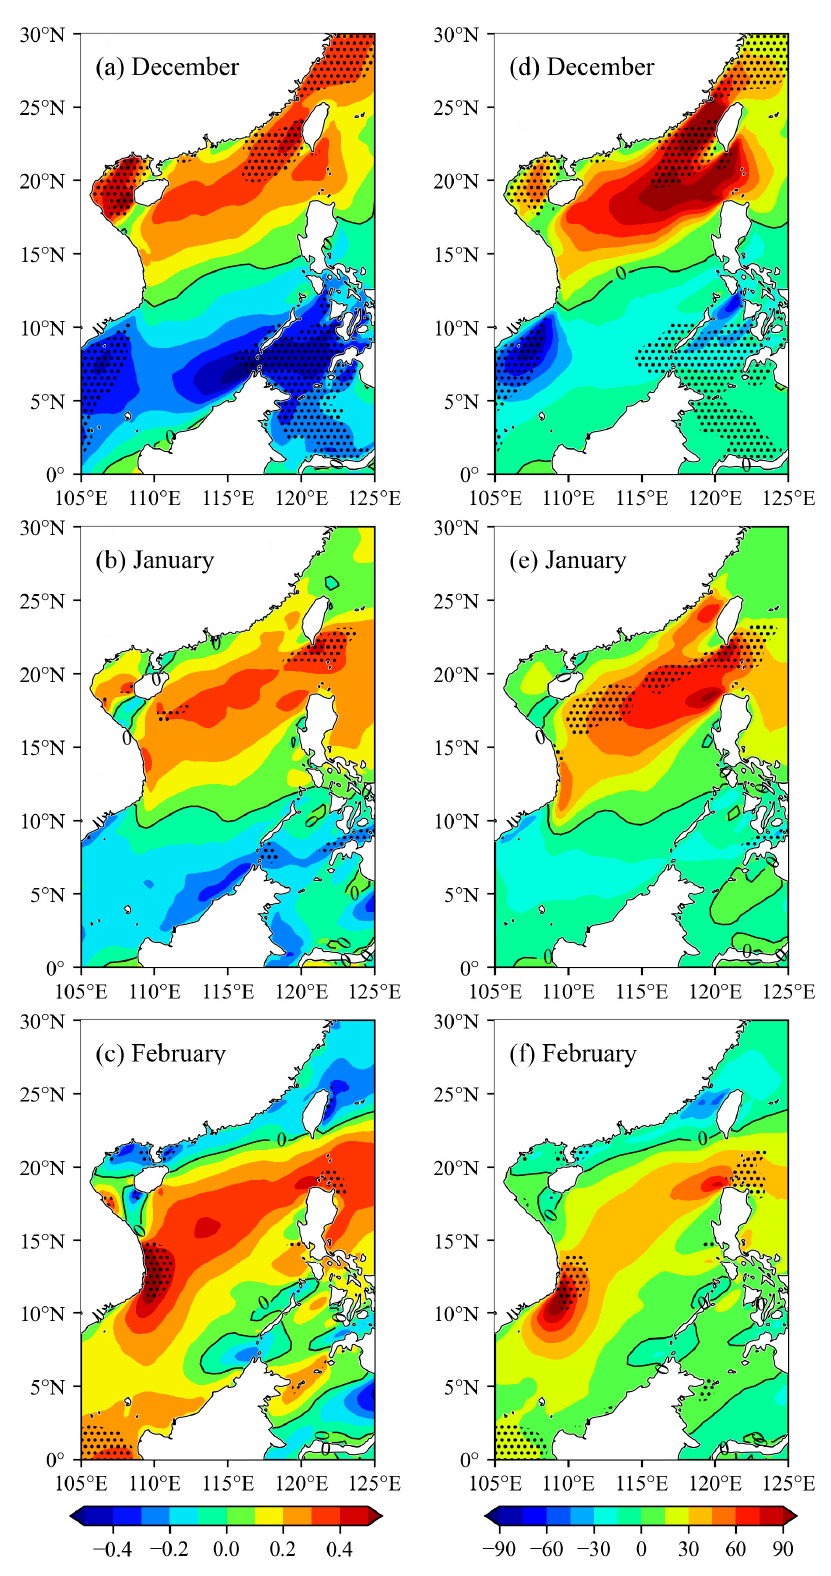
Figure 7. The linear variation trends of the monthly mean wind (a–c, unit: m ‧ s − 1 ‧ (10a) − 1 ) and wind power density (b–f, unit: W ‧ m − 2 ‧ (10a) − 1 ) over the SCS from 1979 to 2021. The black dots indicate the significant areas with more than a 95% confidence level (which was achieved by using Student’s t - test). ( a ) and ( d ): December; ( b ) and ( e ): January; and ( c ) and ( f ): February.